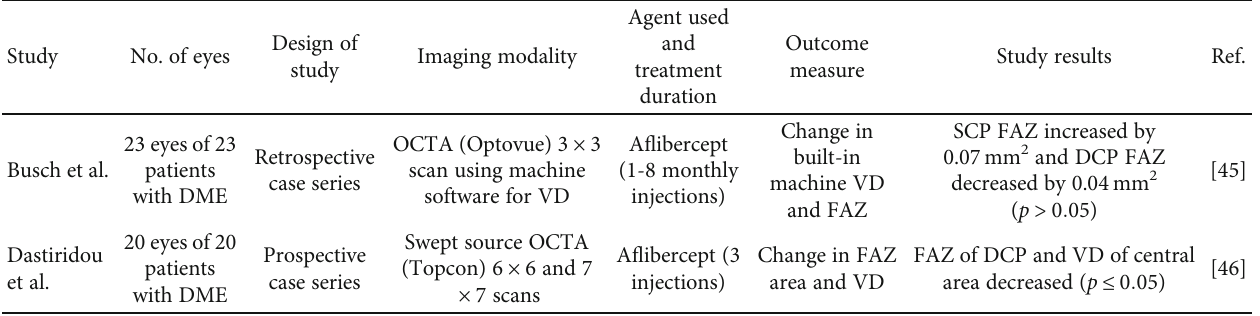
Table 3: Study design, methods, and results of studies that found con fl icting e ff ects following treatment. Study No. of